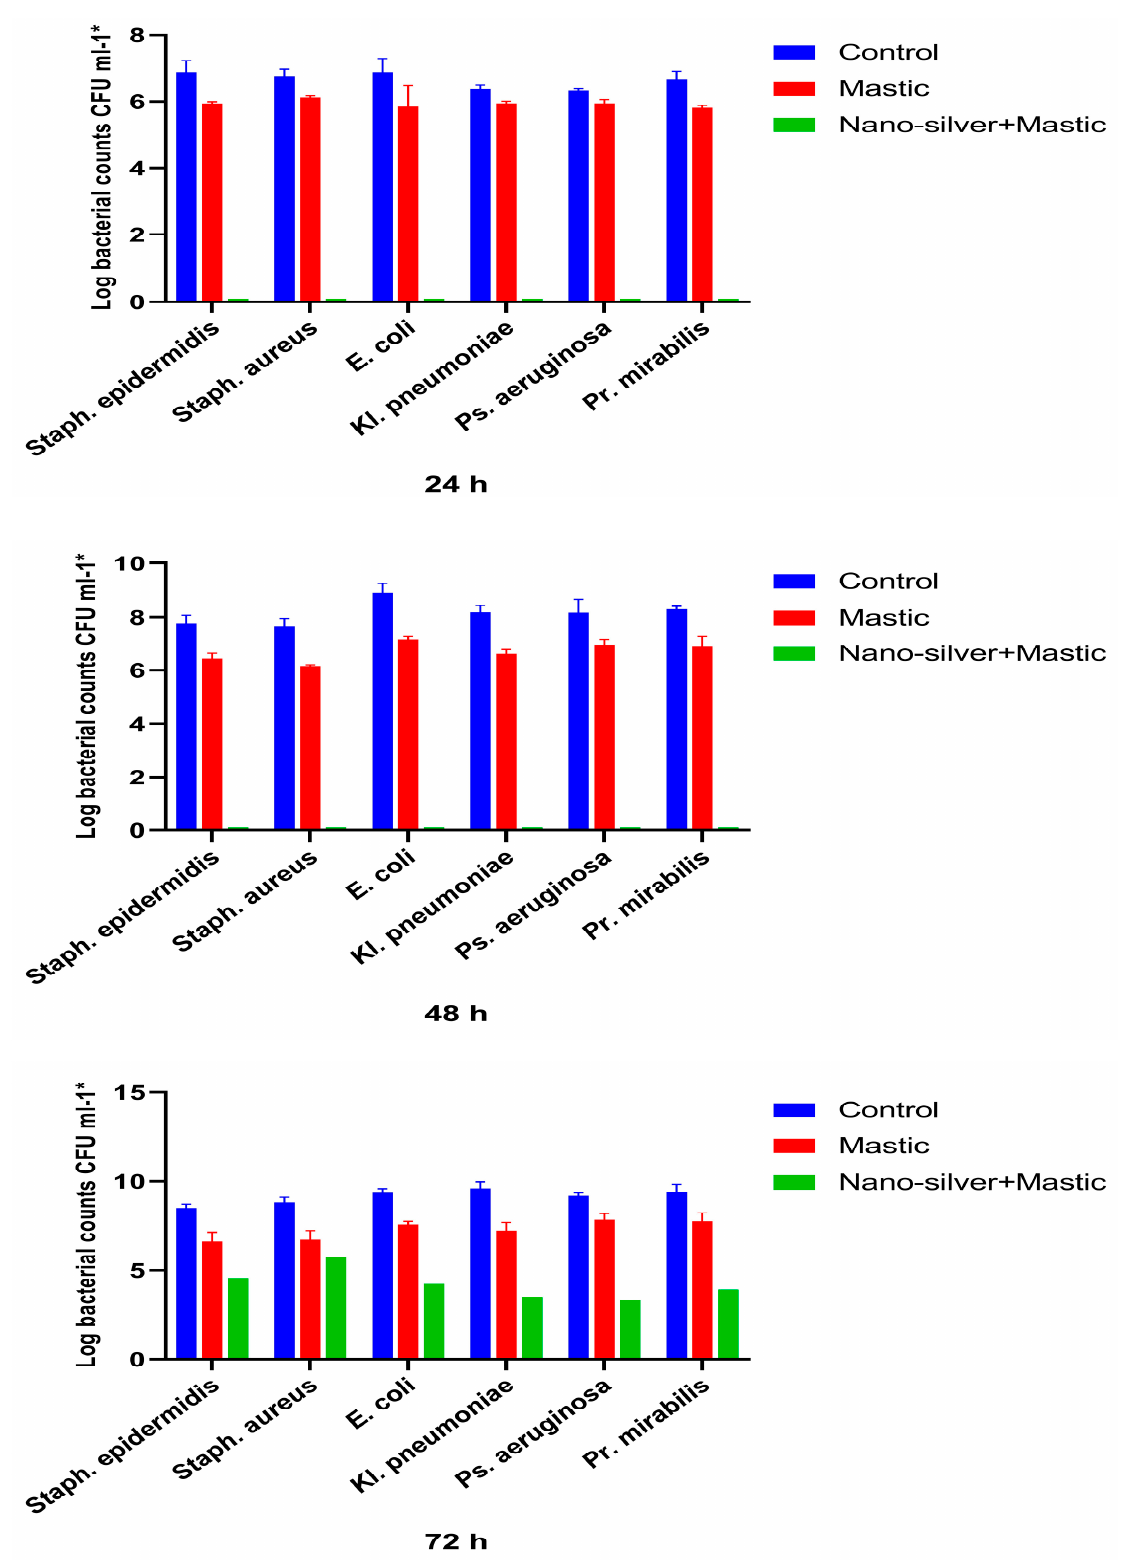
Figure 6. Inhibitory effects of silver nanoparticles and Pistacia lentiscus on the adherence of different types of bacterial cells to the surface of 1 cm silicon catheter.